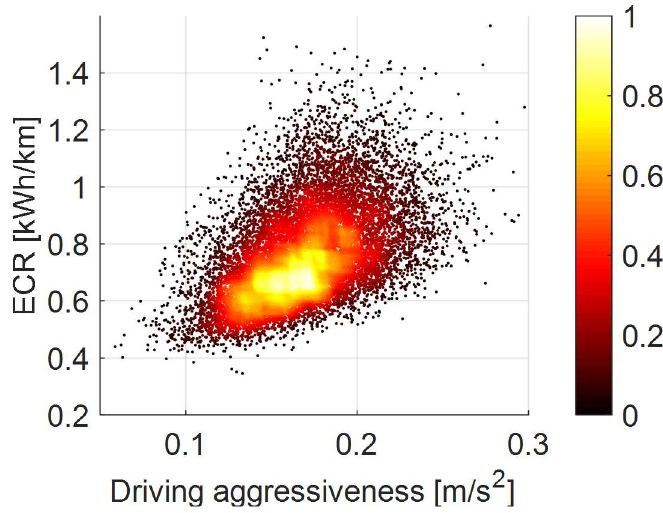
Figure 8. The relation between driving aggressiveness and ECR.